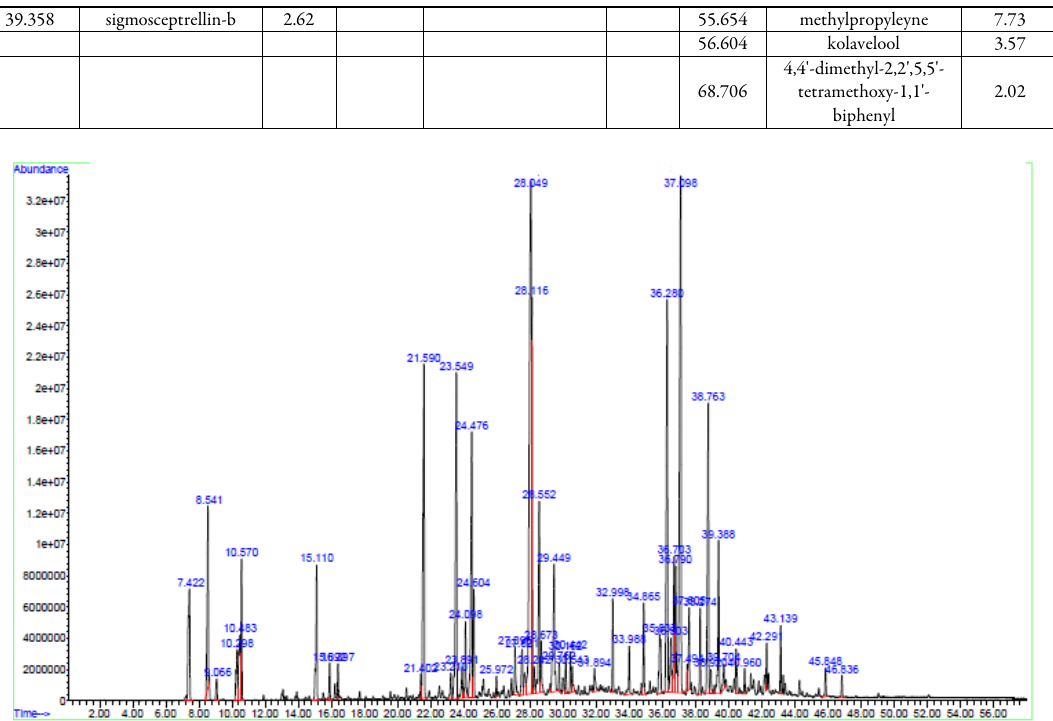
Figure 1. Gas chromatogram of the essential oil of ‘Çakmar’ pink flowers